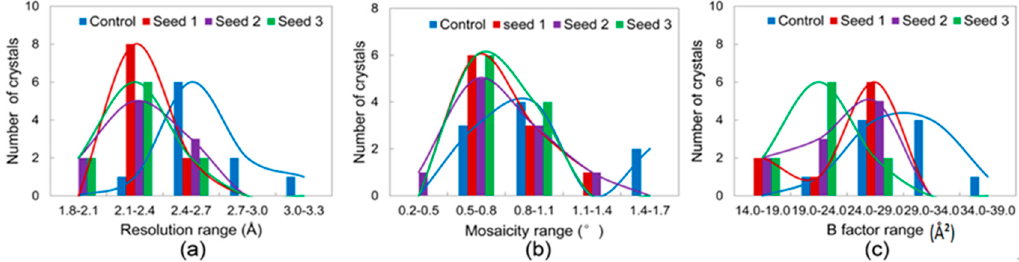
Figure 9. Comparisons of the number of proteinase K crystals calculated by increases of ( a ) 0.2 Å in resolution range, ( b ) 0.3° in mosaicity range, and ( c ) 3 Å² in B-factor range.